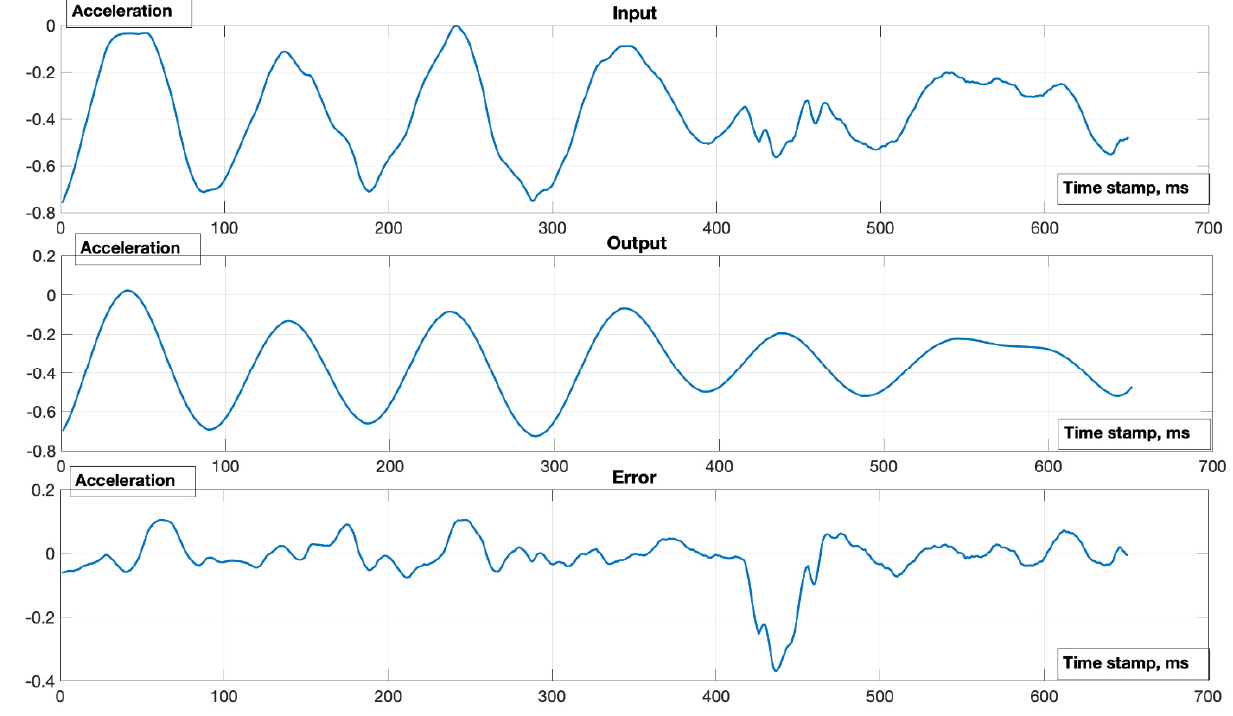
Figure 8. AE validation phase—reconstruction of the anomalous signal.